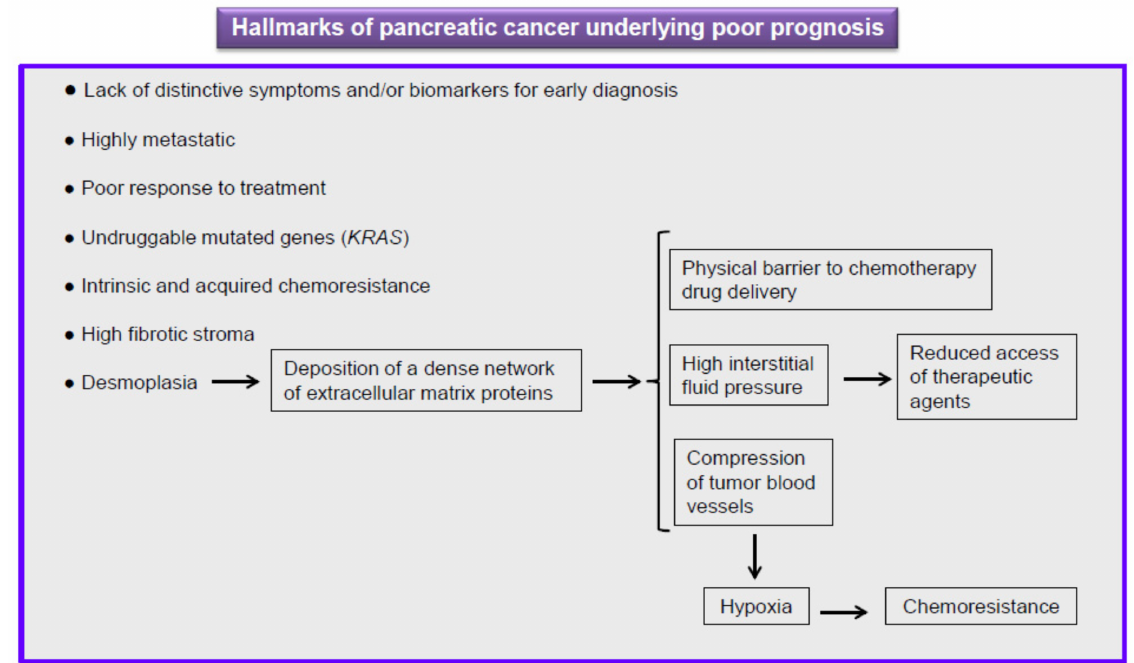
Figure 3. Major hallmarks in pancreatic cancer that affect chemotherapy and underlie poor prognosis. Treatment of metastatic pancreatic cancer relies on chemotherapeutic regimens, with FOLFIRINOX (folinic acid, 5-fluorouracil, irinotecan and oxaliplatin) and nanoparticle albumin-bound paclitaxel (nab-paclitaxel, Abraxane) plus gemcitabine as first-line